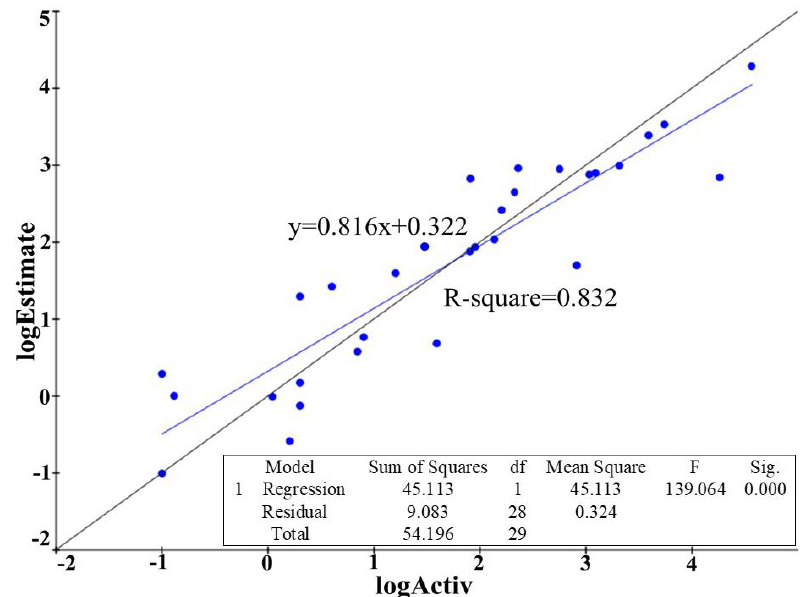
Figure 4. Derivation of r 2 from the plot of log Activ vs. log Estimate of the best hypothesis built on receptor-ligand complex. The standard deviation is 0.57, root mean square error is 0.912, R-square (r 2 ) is 0.832 and the F-statistics is 139.064.